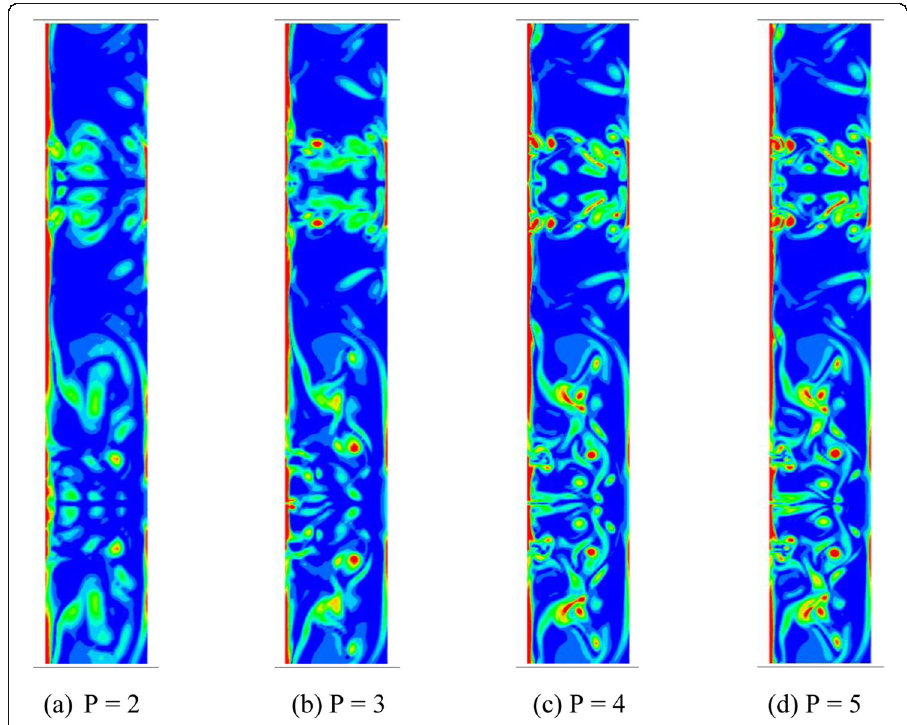
Fig. 7 The vorticity distributions at t 3 computed with different